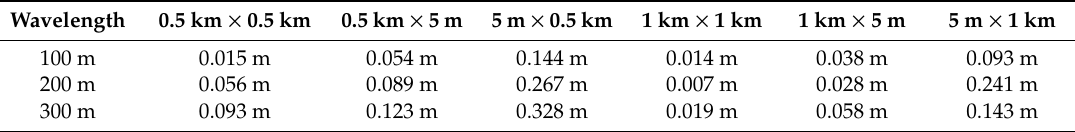
Table 10. The RMS of smoothing velocity bunching height inversion results with di ff erent wavelength (the direction of the smoothing window is in two directions at the same time, in the azimuth and in the